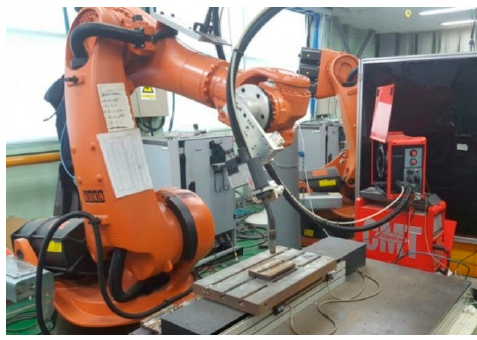
Figure 2. Picture of the arc welding system used.